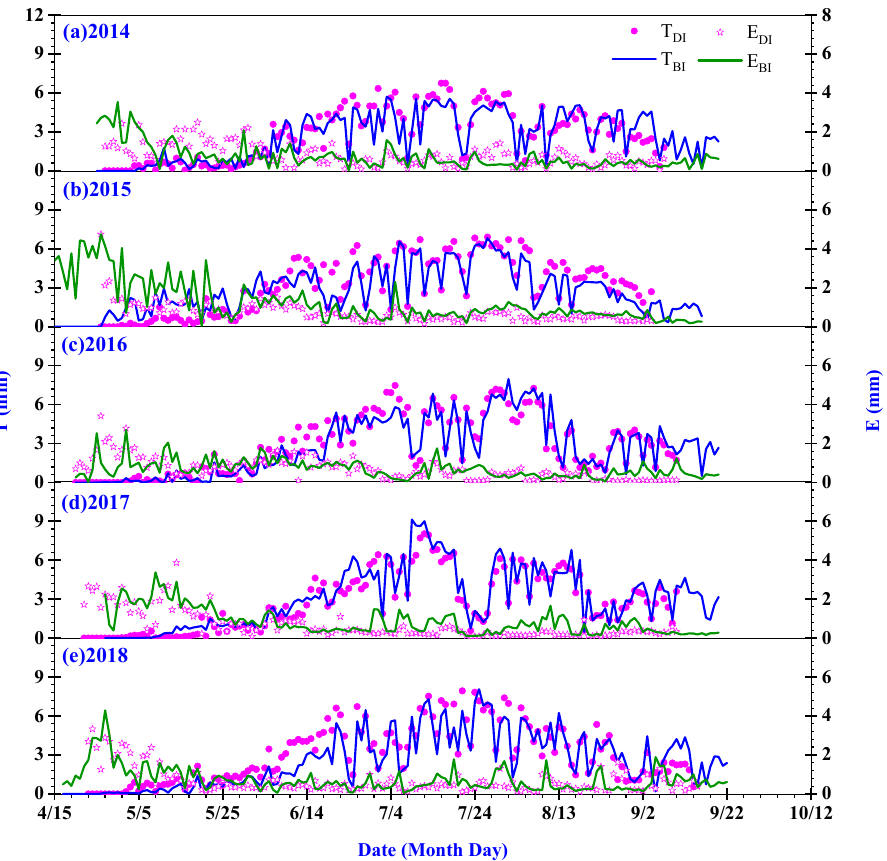
Figure 5. Seasonal variations of daily transpiration (T) measured by sap flow and daily evaporation (E) measured by micro-lysimeters under film mulching border irrigation (BI) treatment and film mulching drip irrigation (DI) treatment during 2014–2018.